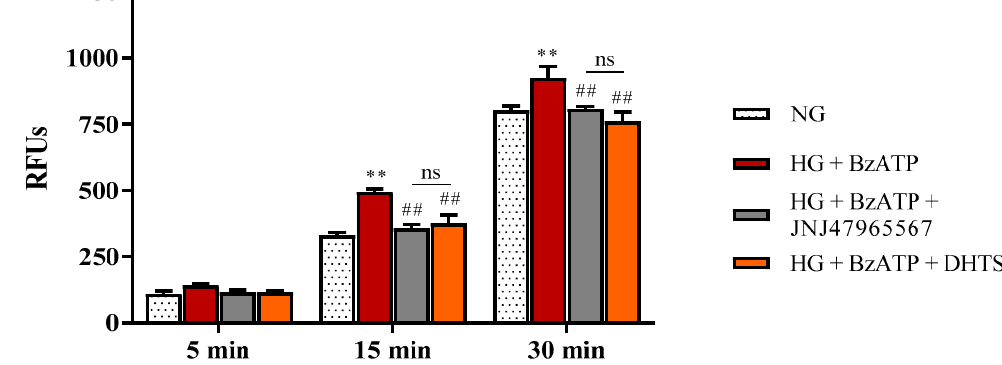
Figure 2. Assessment of barrier integrity in the in vitro human primary culture based on triple co-culture iBRB model by TEER under our experimental conditions. TEER values were measured at time 0 (T0), and after 24 (T24) and 48 (T48) h. NG = normal glucose condition (5 mM). HG = high glucose condition (40 mM). BzATP = 200 µM. JNJ47965567 = 100 nM. DHTS = 500 nM. Values are reported as means ± standard deviation (SD) of three independent experiments. Statistical analysis was performed using two-way analysis of variance (ANOVA) with Tukey’s post-hoc analysis. * p < 0.05 vs. NG. *** p < 0.001 vs. NG. # p < 0.05 vs. HG + BzATP. ### p < 0.001 vs. HG + BzATP. ns = not significant.